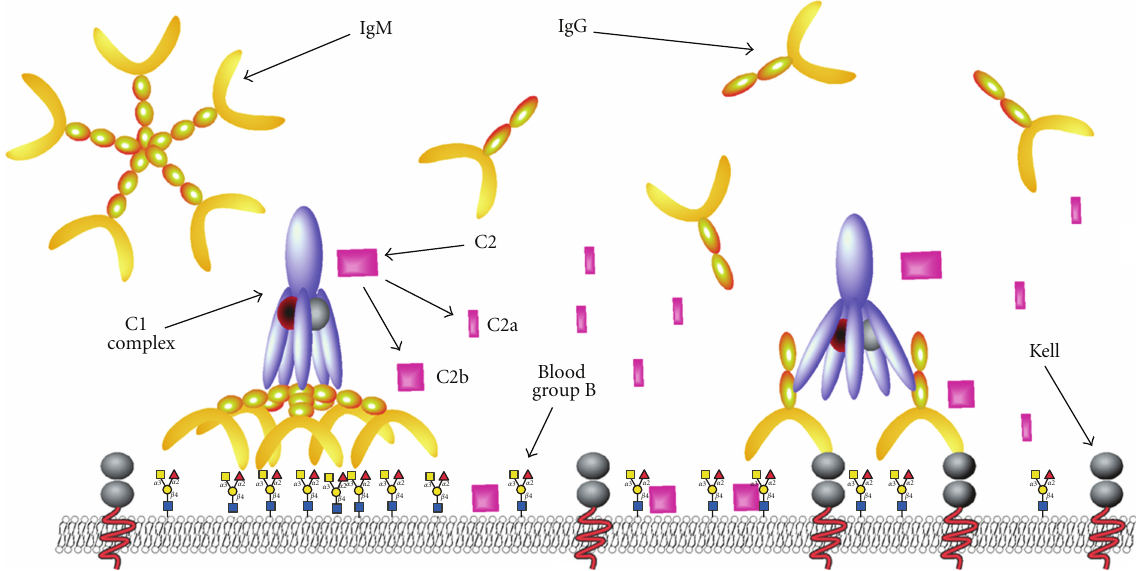
Figure 1: Antibody-mediated complement activation. IgM antibodies primarily exist as planar molecules. However, upon engagement of antigen, IgM antibodies undergo significant conformation changes that result in favorable exposure of multiple C1q binding domains. As a result, a single IgM molecule can initiate significant complement activation. In contrast, two separate IgG antibodies must engage antigen within close enough proximity to simultaneously engage the C1q fix